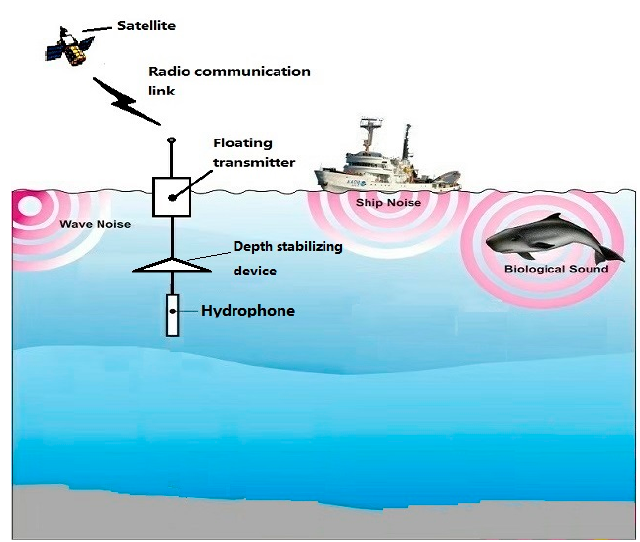
Figure 1. Schematic diagram of buoy and submerged buoy system.